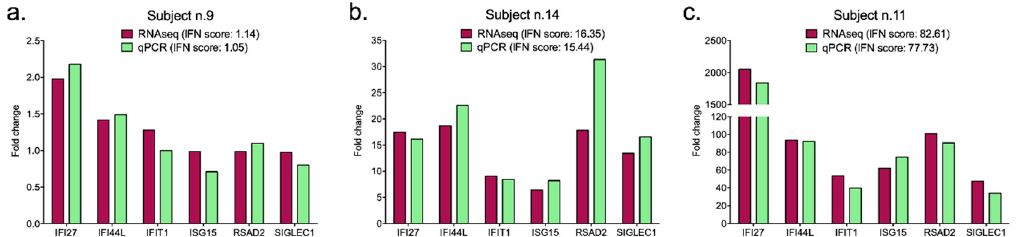
Figure 2. Representative display of low ( a ), intermediate ( b ) and high ( c ) IFN signatures analyzed by both qPCR and RNAseq for each subject. For the optimal graphical representation of all histograms, the scales of values are set different. The IFN scores computed for each subject are reported in the legend of the figures.